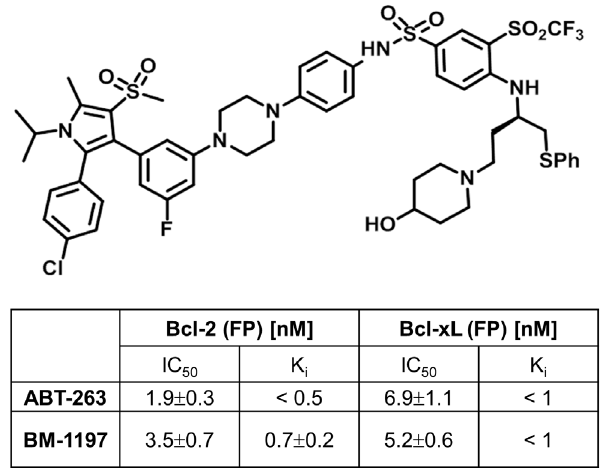
Figure 1. Chemical structure and binding affinities of BM-1197. The binding affinities of BM-1197 and ABT-263 to Bcl-2 and Bcl-xL determined by fluorescence-polarization binding assay. Data are expressed as means 6 SD (n $ 3).